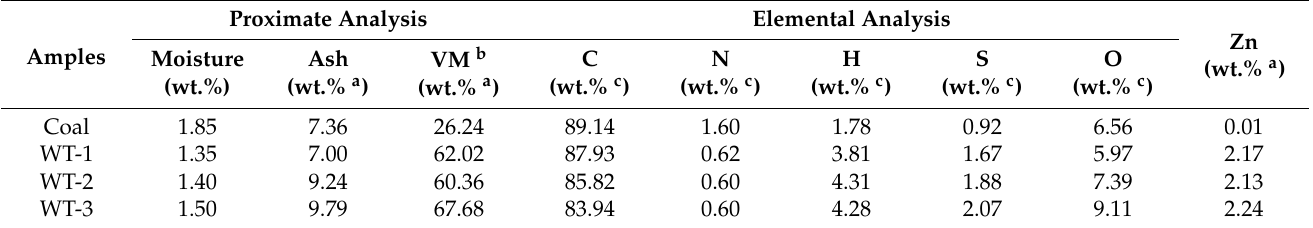
Table 1. Characteristics of coal and tire wastes.